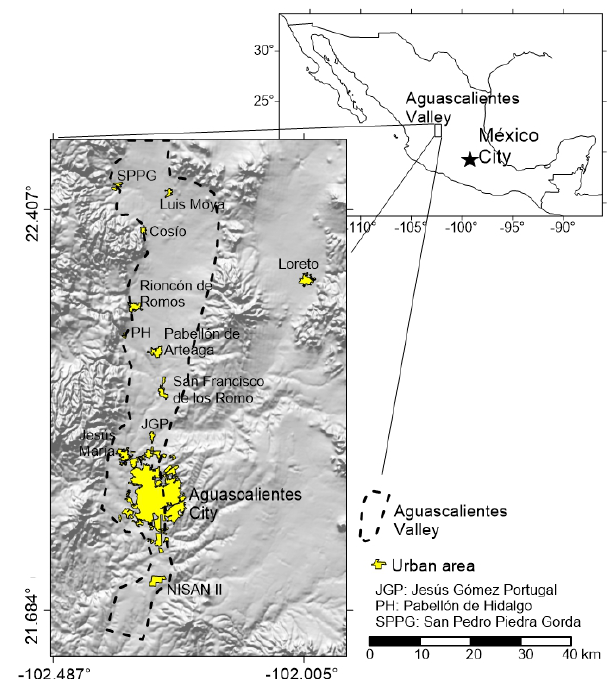
Figure 1. Location of Aguascalientes Valley. The names of minor cities and small towns are provided in the map legend.